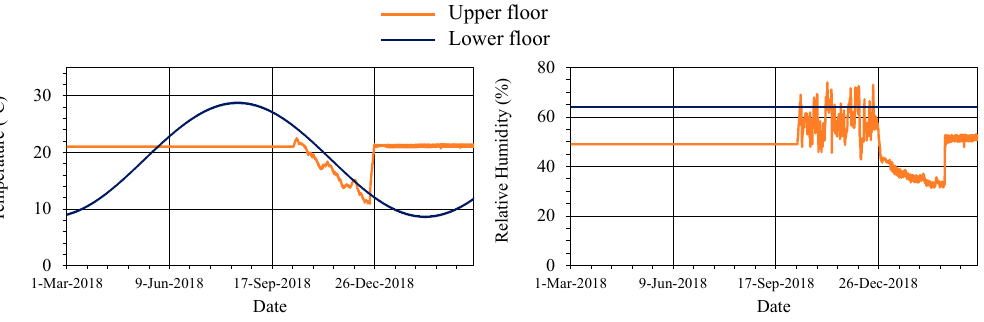
Figure 9. Input temperatures and RHs for the upper and lower rooms.